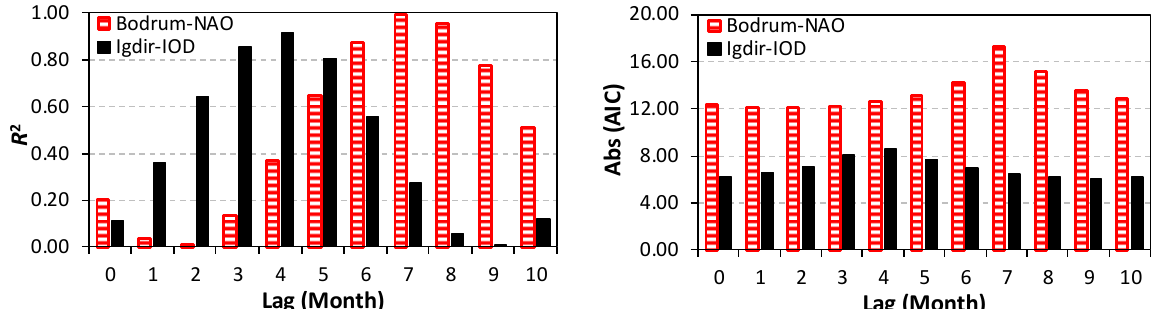
Figure 17. Results of statistical analysis of Bodrum-NAO and Igdir-IOD. Table 3. The R 2 and Akaike information criterion (AIC) values for Bodrum-NAO and Igdir-IOD (Bold values indicate highest relationship).